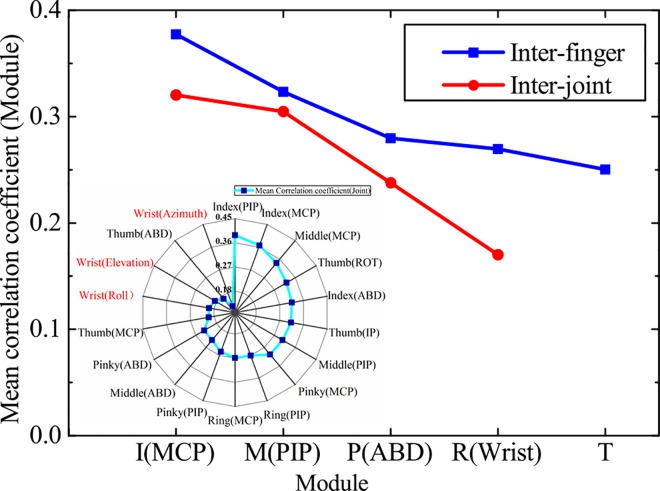
Mean correlation coefficient analysis on modules and joints.The I, M, P, R and T of abscissa denote module of inter-joint, middle figner, ring finger, pinky and thumb, respectively. The MCP, PIP, ABD and wrist denote corresponding inter-joint module.